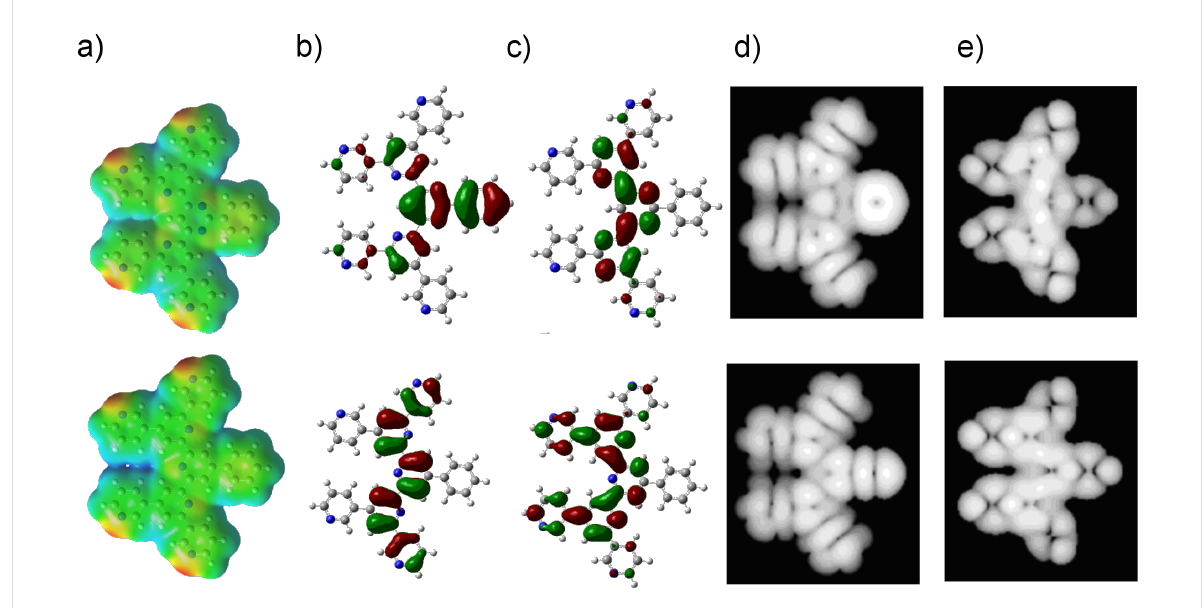
Figure 8: Electronic properties for 3,3'-BTP ( 3 ) (top) and 3,3'-PhSpPy ( 15 ) (bottom). (a) Electrostatic potential, (b) HOMO, (c) LUMO, and simulated STM images of (d) occupied and (e) unoccupied orbitals. The energy levels of LUMO and HOMO for 3,3'-BTP ( 3 ) are − 9.46 kJ mol − 1 and − 24.31 kJ mol − 1 , respectively, and for 3,3'-PhSpPy ( 15 ) − 8.59 kJ mol − 1 and − 23.83 kJ mol − 1 ,